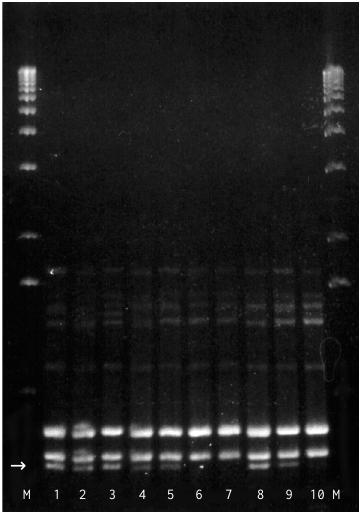
Figure 2 - Electrophoretic patterns of genomic DNA extracted from indi- viduals from one hybrid colony of M. quadrifasciata , amplified with primer OPE-07. Lanes are as follows: M, 1-kb DNA ladder size markers; 1-10, different individuals from the hybrid colony. The arrow indicates a band present only in individuals from the subspecies M. q. quadrifasciata .